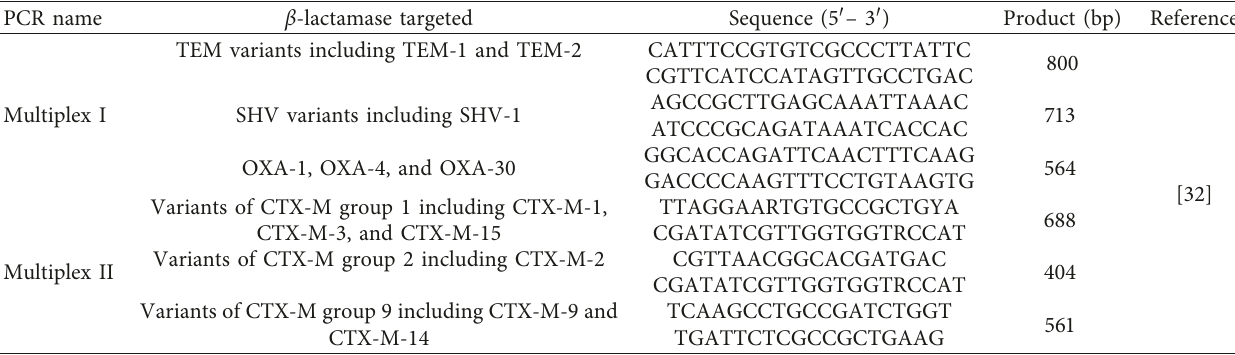
Table 2: Multiplex PCR-specific primers used for ESBL gene detection in Enterobacteriacaea .